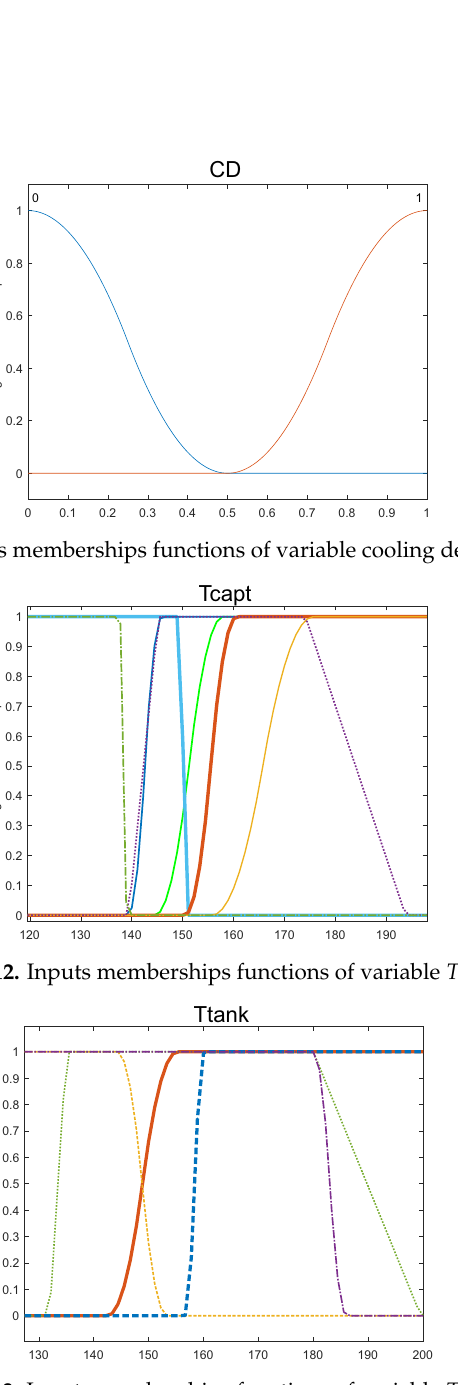
Figure 13. Inputs memberships functions of variable T tank .